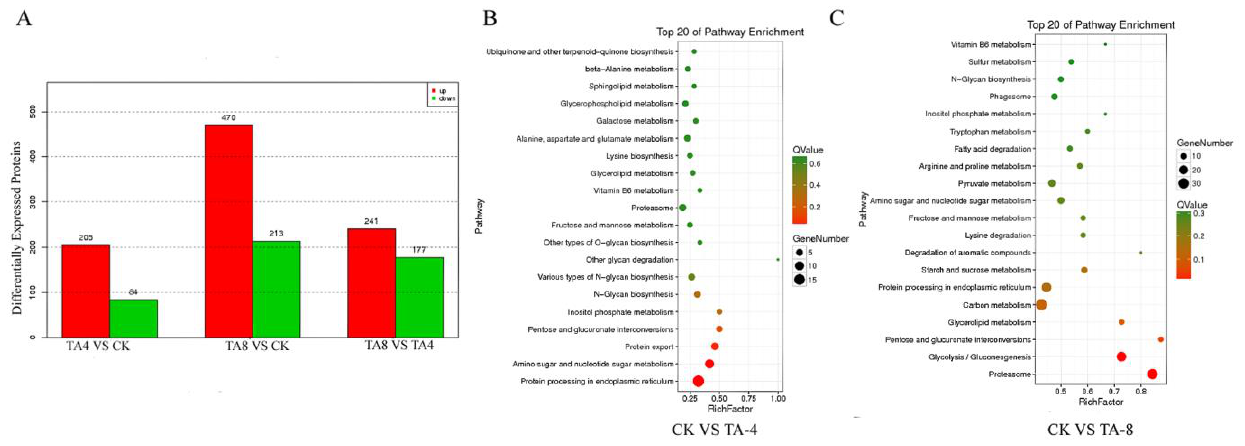
Figure 5. The differential proteins and KEGG pathway enrichment after TA treatment: ( A ) Differ- entially expressed proteins; ( B ) KEGG pathway enrichment of CK VS TA-4; ( C ) KEGG pathway enrichment of CK VS TA-8.